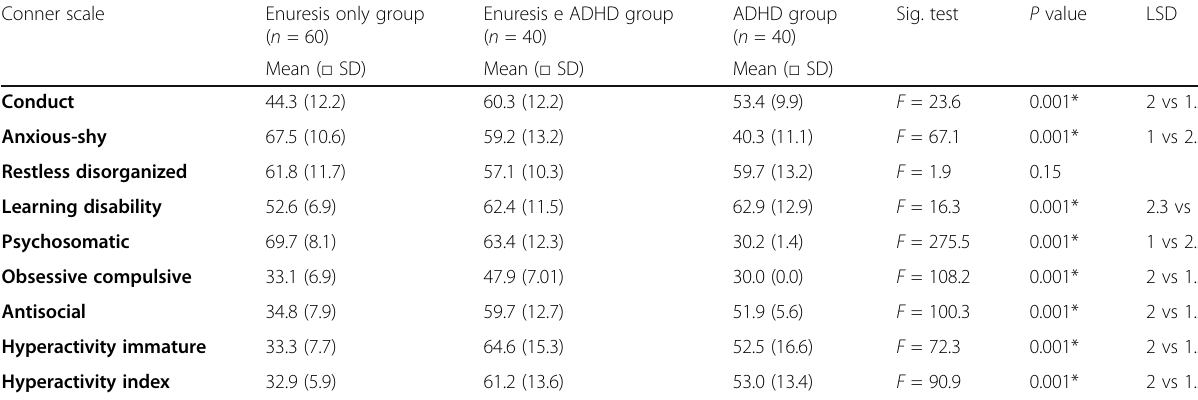
Table 4 Comparison between Conners ’ parent rating scale (CPRS-93) of the 3 studied groups Conner scale